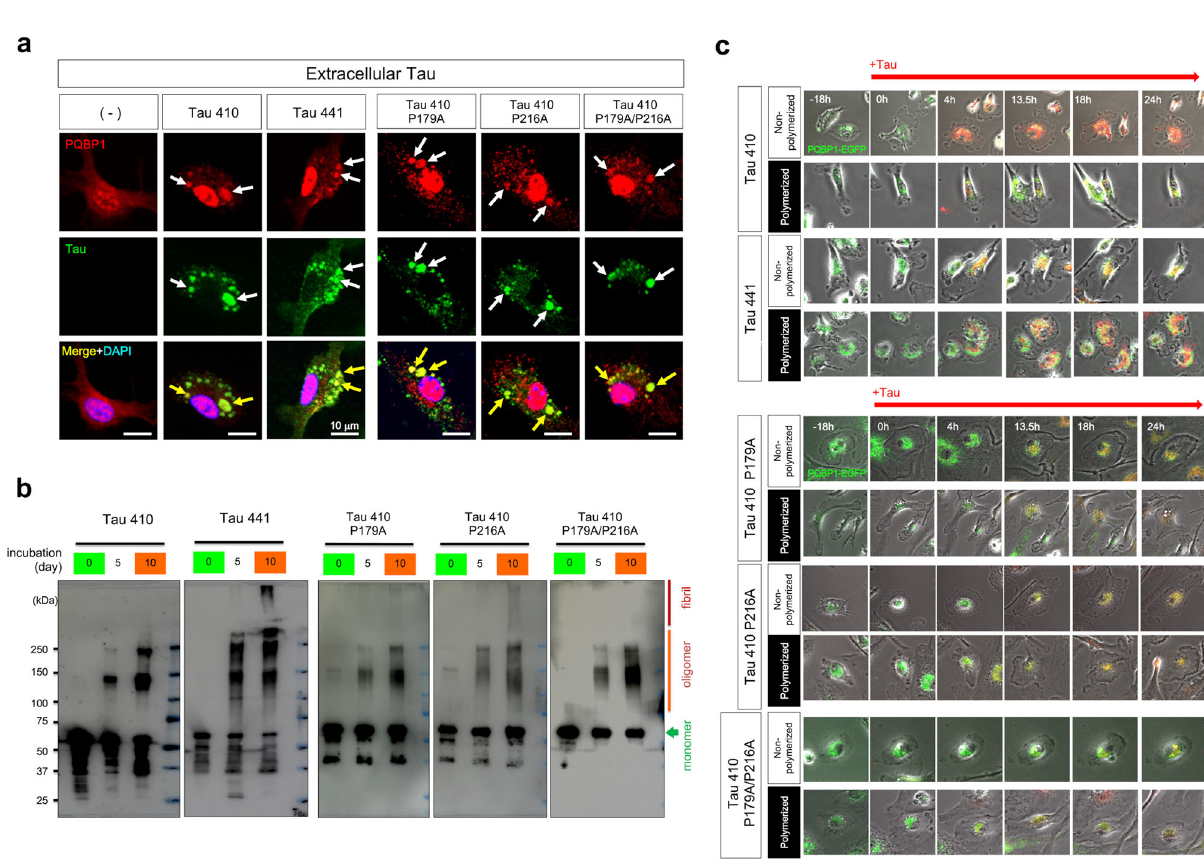
Fig. 2 Colocalization of PQBP1 and incorporated Tau in microglia. a Immunocytochemistry of primary microglia prepared from C57BL/6 mice cultured with Tau 410, Tau 441, Tau 410 P179A, Tau 410 P216A, or Tau 410 P179A/P216A proteins in the medium. Colocalization of PQBP1 and extrinsic tau was detected frequently. The experiments were repeated four times independently with similar results. b In vitro polymerization of Tau 410, Tau 441, Tau 410 P179A, Tau 410 P216A, and Tau 410 P179A/P216A full-length proteins. Only Tau 441 and Tau 410 P216A partially formed fi brils after 10 days of incubation, while the other full-length protein did not. The experiments were repeated four times independently with similar results. c Images of normal microglia before and after addition of polymerized or non-polymerized Tau 410, Tau 441, Tau 410 P179A, Tau 410 P216A, or Tau 410 P179A/P216A, among which three species are shown in Supplementary Movies 1 – 3. h